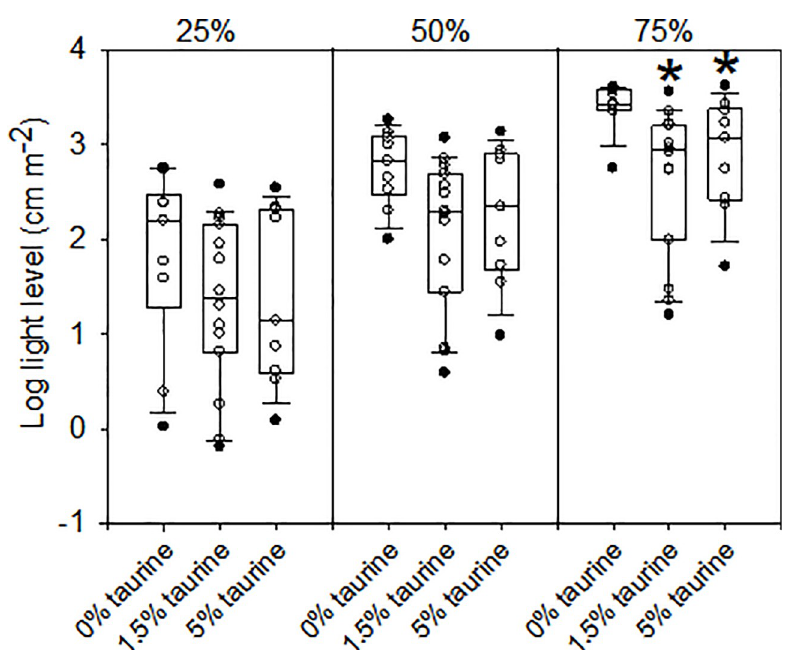
Fig 5. Light levels needed to produce a given response relative to that of the maximin response in intensity– response curves (Fig 4). The solid lines within the boxes mark the median values, the boundaries of the boxes the 25 th and 75 th percentiles, and the whiskers (error bars) above and below the boxes the 90 th and 10 th percentiles. Data points between the 90 th and 10 th percentiles are shown as open circles and those outside this interval as filled circles. Significant differences between median values from fish fed 0% and 1.5% taurine diets and those between median values from fish fed 0% and 5% taurine diets are indicated by the � symbol (p-values were 0.002 and 0.044, respectively).